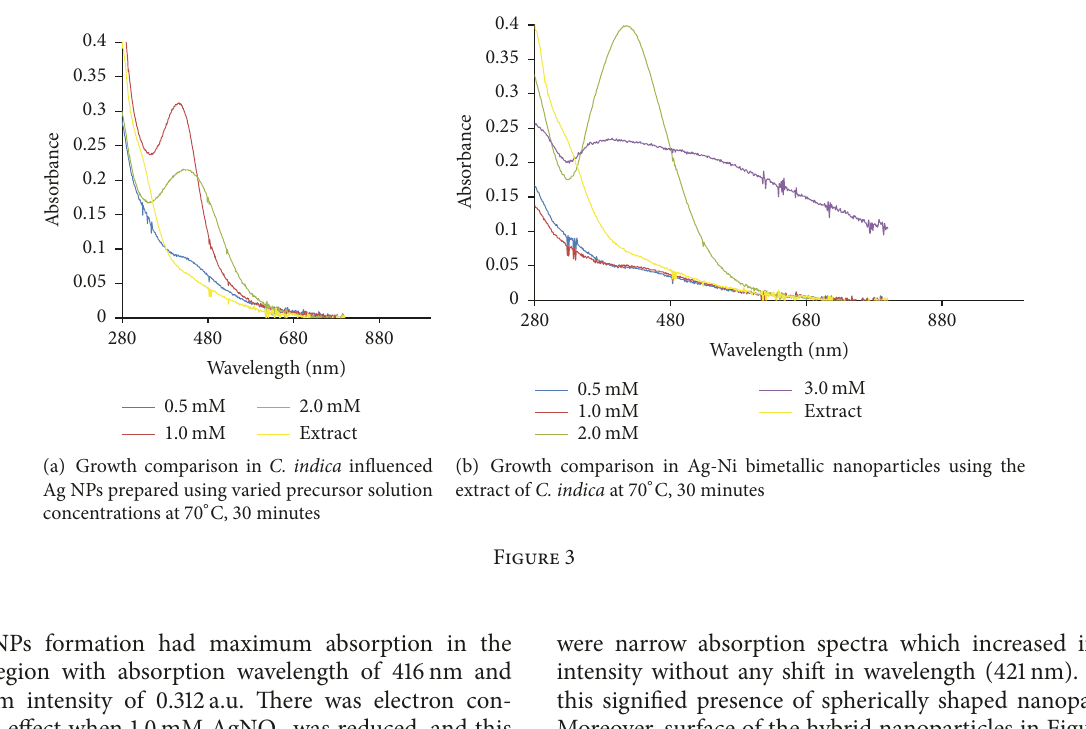
Figure 2: UV-Vis spectra of Ag/Ni bimetallic nanoparticles prepared by reducing (a) 0.5 mM, (b) 1.0mM, (c) 2.0 mM, and (d) 3.0 mM solutions using the extract of C. indica leaves at 70 ∘ C. The blue curve represents surface plasmon resonance after 30 minutes.